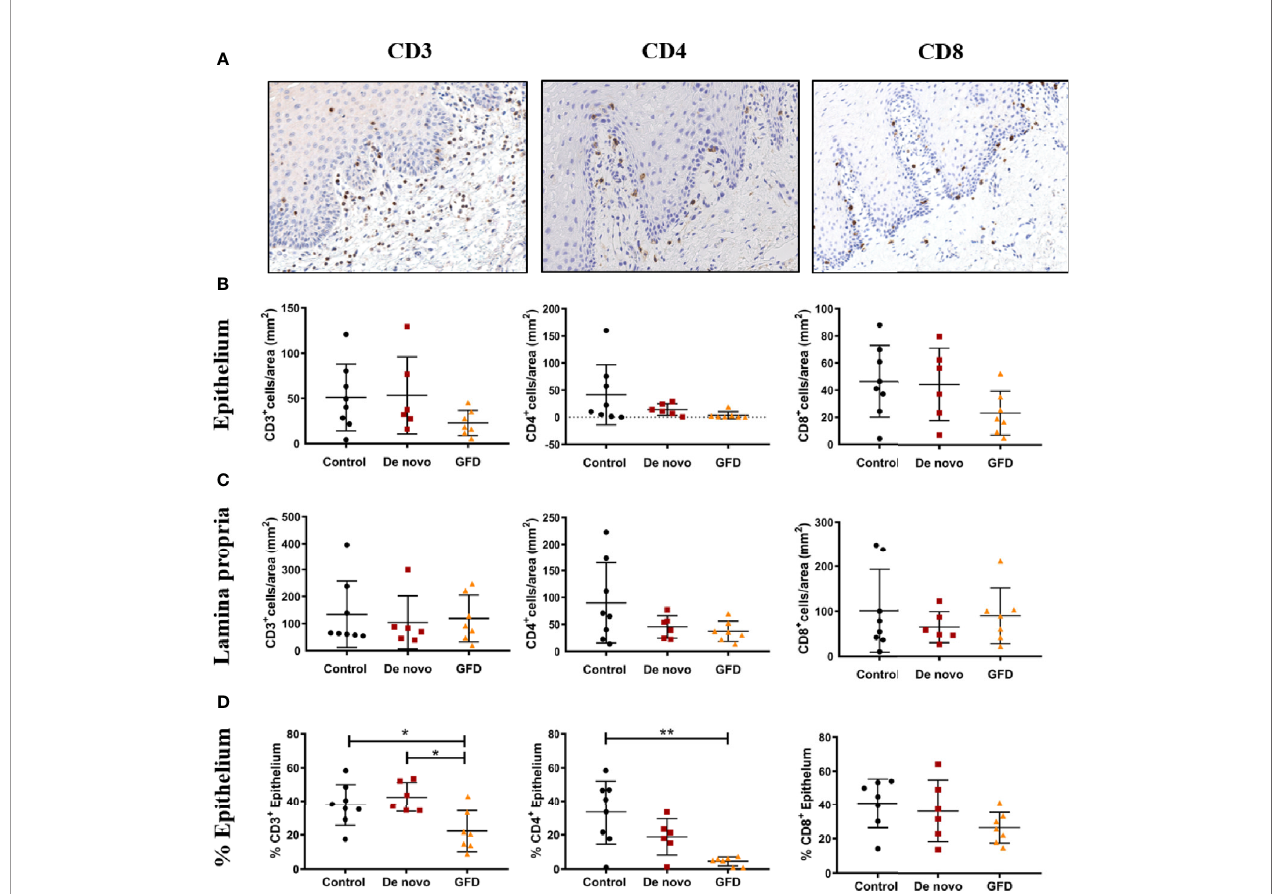
FIGURE 2 | Representative images of CD3, CD4, CD8 immunohistochemistry (A) . Images were captured at 15× magni fi cation. Absolute counts in epithelium (B) , absolute counts in lamina propria (C) , and frequency of cells present in the epithelium (%) (D) for CD3+ (left), CD4+ (center), and CD8+ (right) from non-celiac subjects (control) (n = 8) and celiac disease patients de novo diagnosed ( de novo ) (n = 6) and after Gluten Free Diet (GFD) (n = 7). Scatter plots show mean ± SD *p < 0.05, **p <